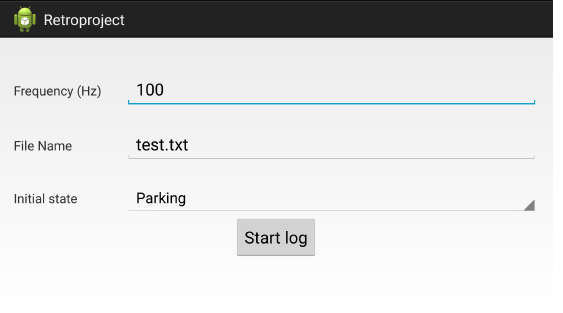
Figure 4. Screenshots of the android app used for data